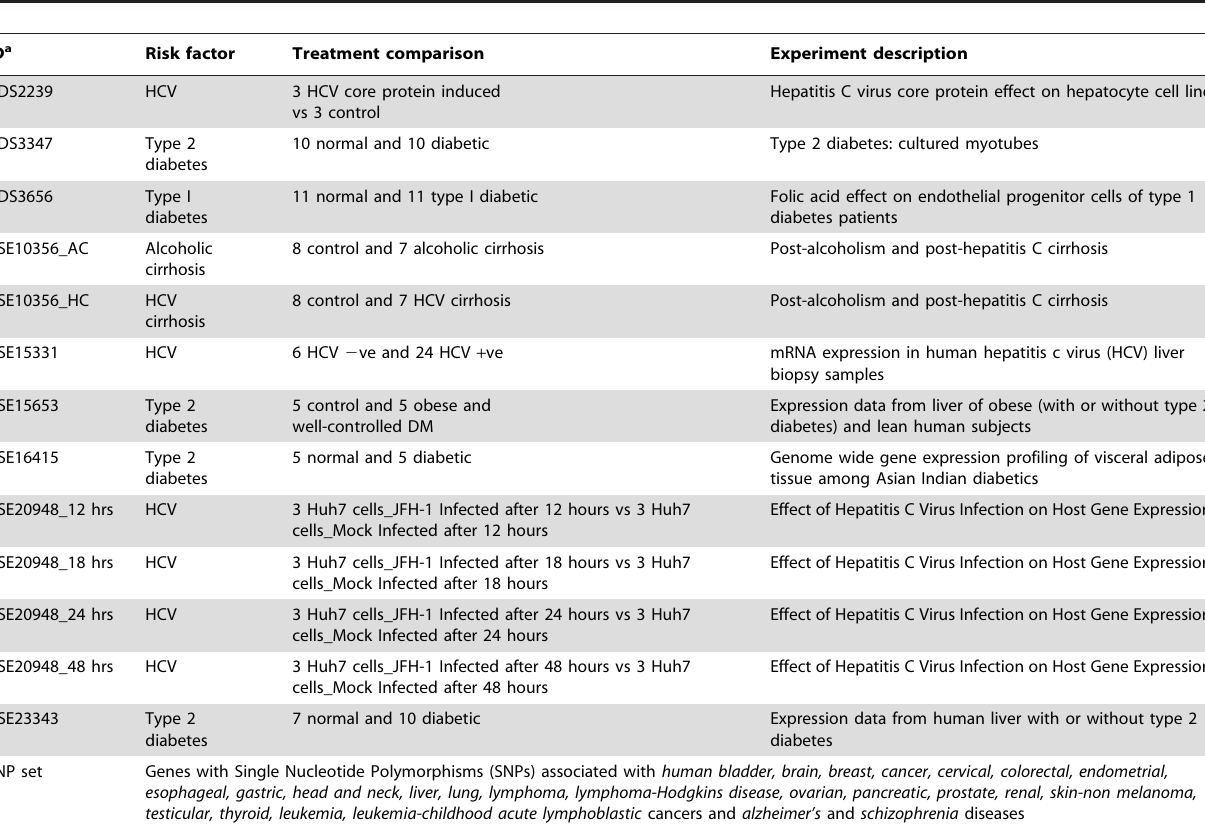
Table 3. Human data sets associated with risk for liver cancer that were used for carcinogenicity predictions.